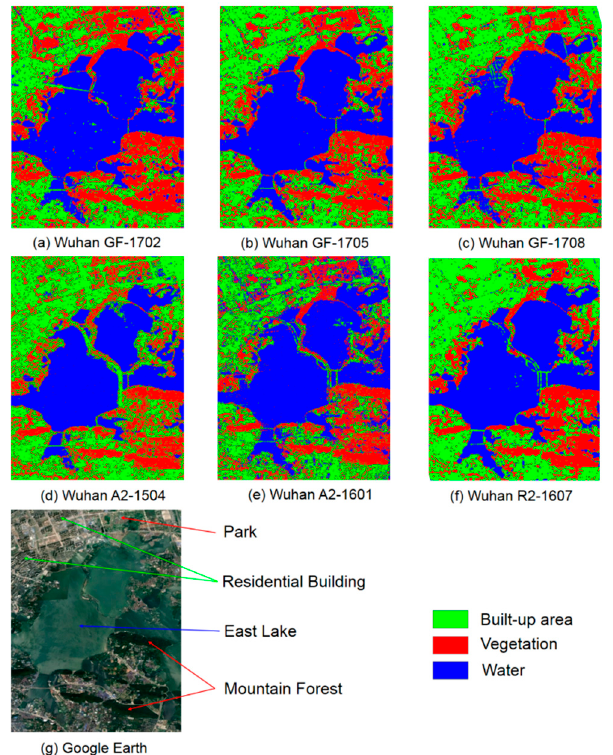
Figure 11. Classification of built-up areas, vegetation, and water in Wuhan.